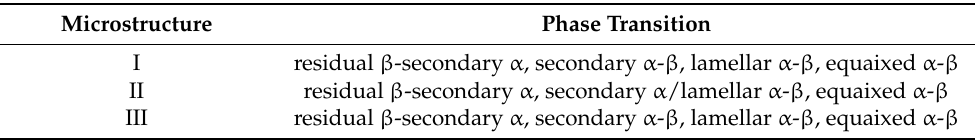
Table 2. Phase transformation sequence in continuous heating of TA15